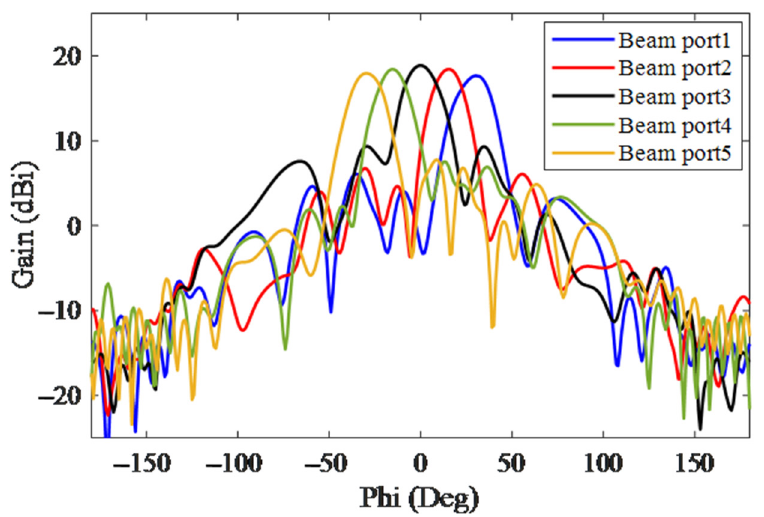
Figure 14. The measured gain of the 2D-MBA for different beam port excitations at 18 GHz.